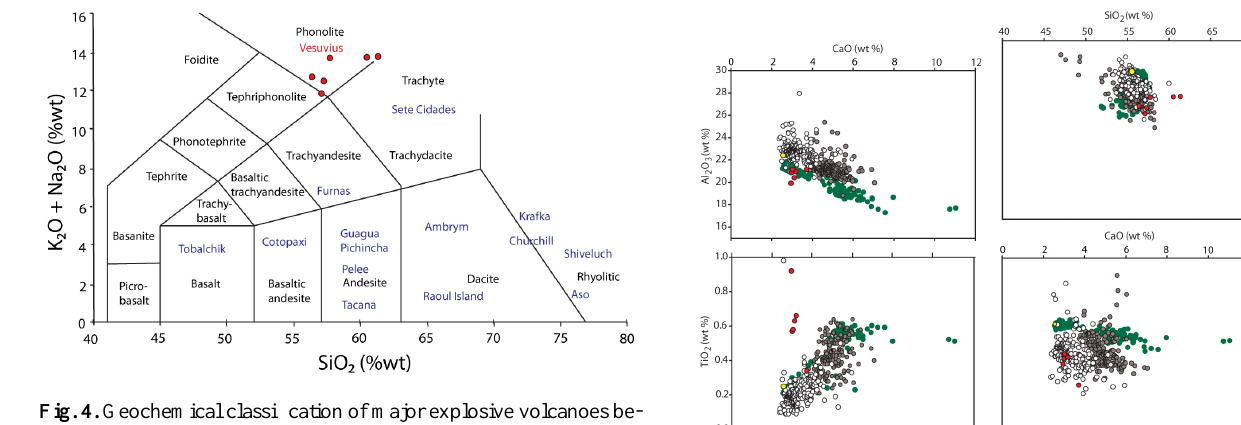
tween 50 to 100AD (see Table 2). The volcanoes are characterized